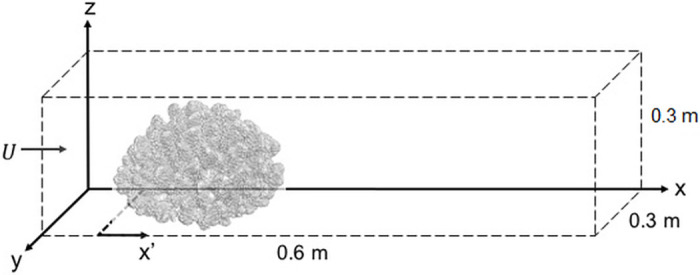
Schematic of the simulation flow domain (not to scale).x′ = 0 is the secondary axis used at the beginning of the coral colony. The center of the colony is located at the middle of the flow domain. Uniform grid spacing was used throughout the domain.